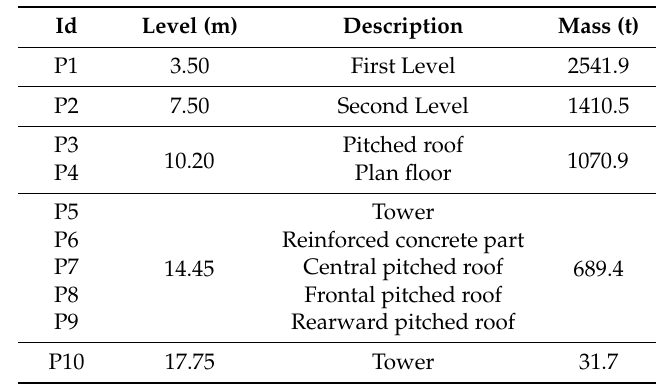
Table 2. Control points of the